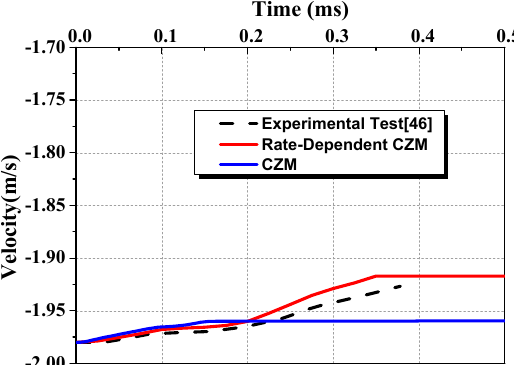
Figure 9. Velocity–time curves of impactor.